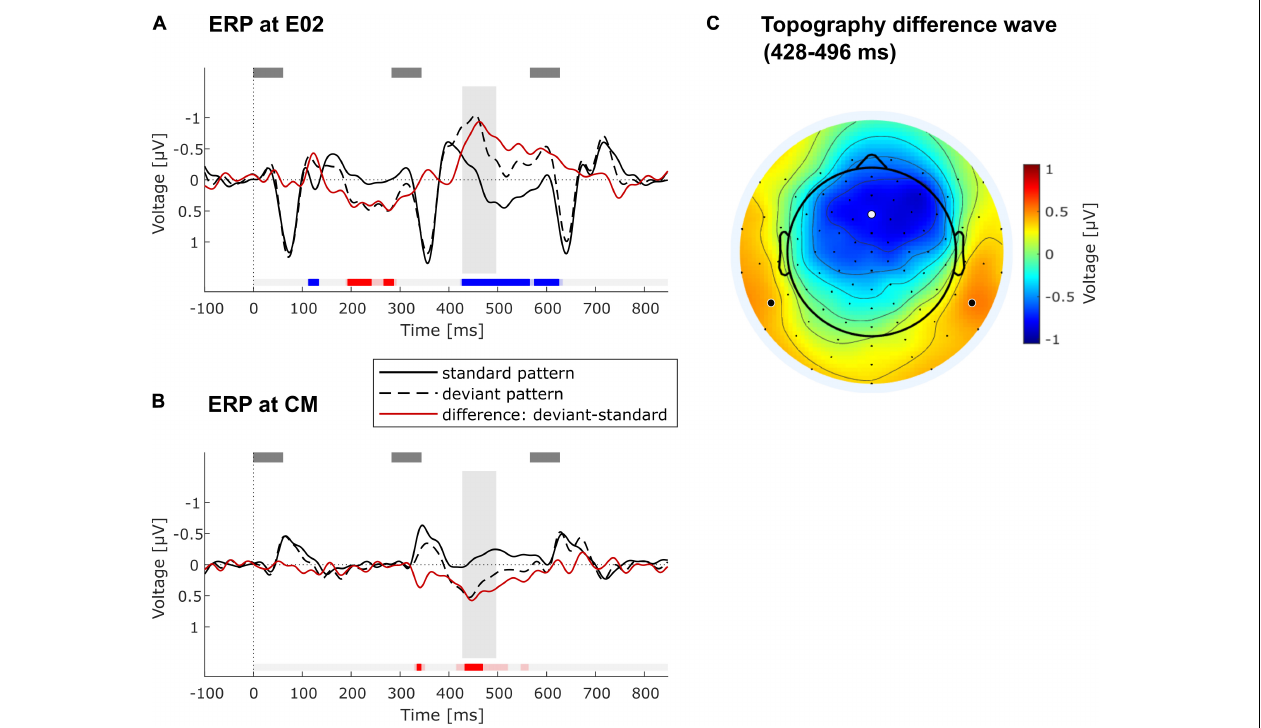
FIGURE 4 | ERP results. (A) Grand-average ERPs at frontocentral electrode position E02 across all included participants ( N = 28) elicited by standard (solid black line) and deviant triplets (dashed black line) as well as their difference wave (red line). Gray rectangles above denote the tones. Timepoint 0 refers to the onset of the second tone in low-low-mid (standard) or low-mid-mid triplet (deviant). Blue/red markings under the ERPs indicate significant negative/positive deviation of the difference wave from zero as determined in running t -test with FDR-correction of the alpha level. Faint blue/red markings show significant negative/positive deviation with alpha level p < 0.05 (without correction). The gray vertical rectangle highlights the chosen time window (428–496 ms) around the peak of the negativity in the difference wave. (B) Grand-average ERPs at common mastoids (CM) across all included participants ( N = 28). All markings, rectangles and lines have the same meaning as in (A) . (C) Topography of the difference wave in the chosen time window (428–496 ms), showing a frontocentral negativity with polarity inversion at the mastoids. The white dot indicates the location of E02 used for the ERP plot in (A) . Bold black dots show channel locations of left and right mastoid (both were averaged for ERP plot in B